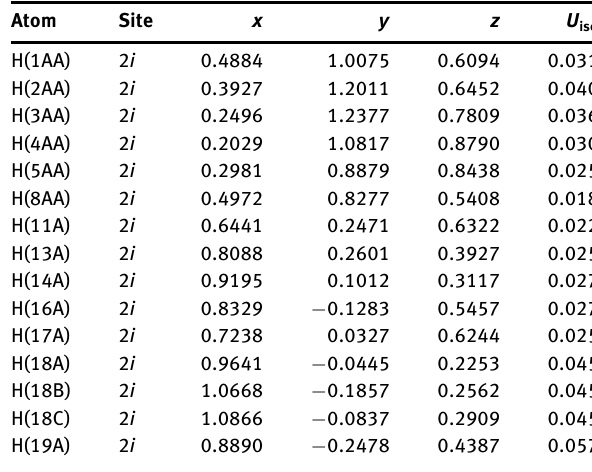
Table 2: Fractional atomic coordinates and isotropic or equivalent isotropic displacement parameters (Å 2